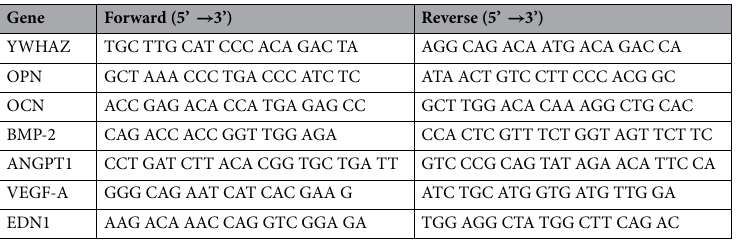
Table 2. Primer pairs used for qPCR. Tyrosine 3-monooxygenase/tryptophan 5-monooxygenase activation protein zeta (YWHAZ; reference gene), secreted phosphoprotein 1/osteopontin (SPP1/OPN), osteocalcin (OCN), bone morphogenic protein-2 (BMP-2), angiopoietin-1 (ANGPT1), vascular endothelial growth factor A (VEGF-A), endothelin 1